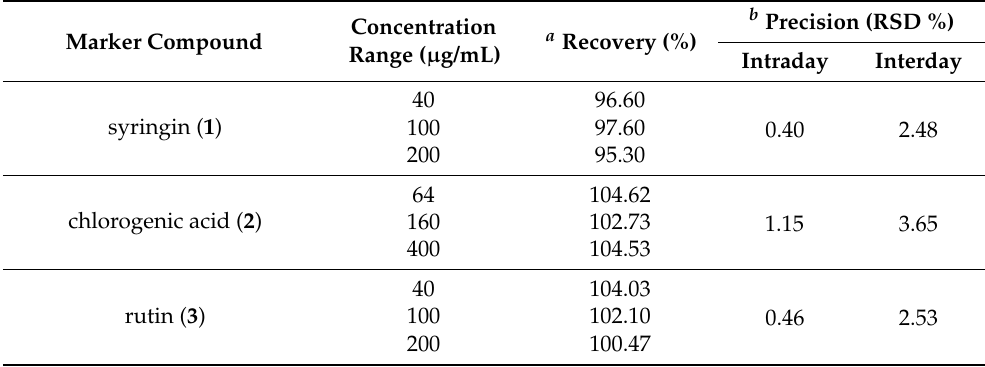
Table 2. Recovery data for the eight marker components in the extract of I. rotunda